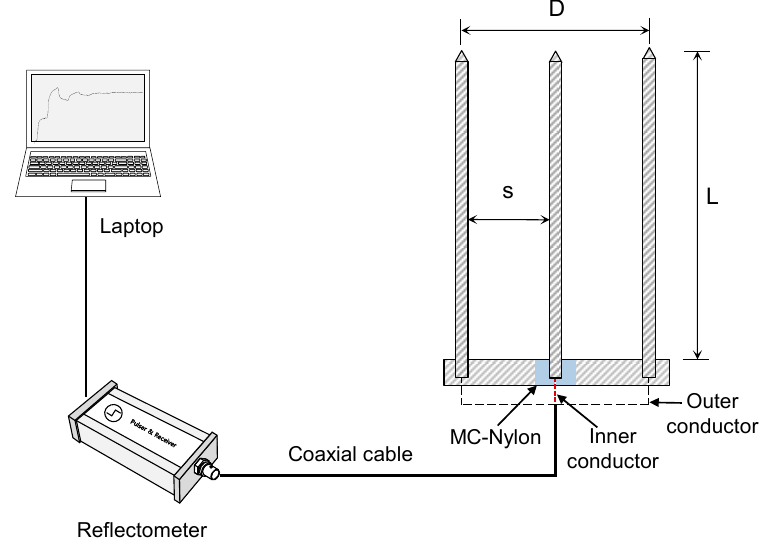
Figure 1. Schematic drawing of the horizontally elongated time domain reflectometry (HETDR) system. s, D, and L indicate the probe spacing, probe width, and probe length, respectively.